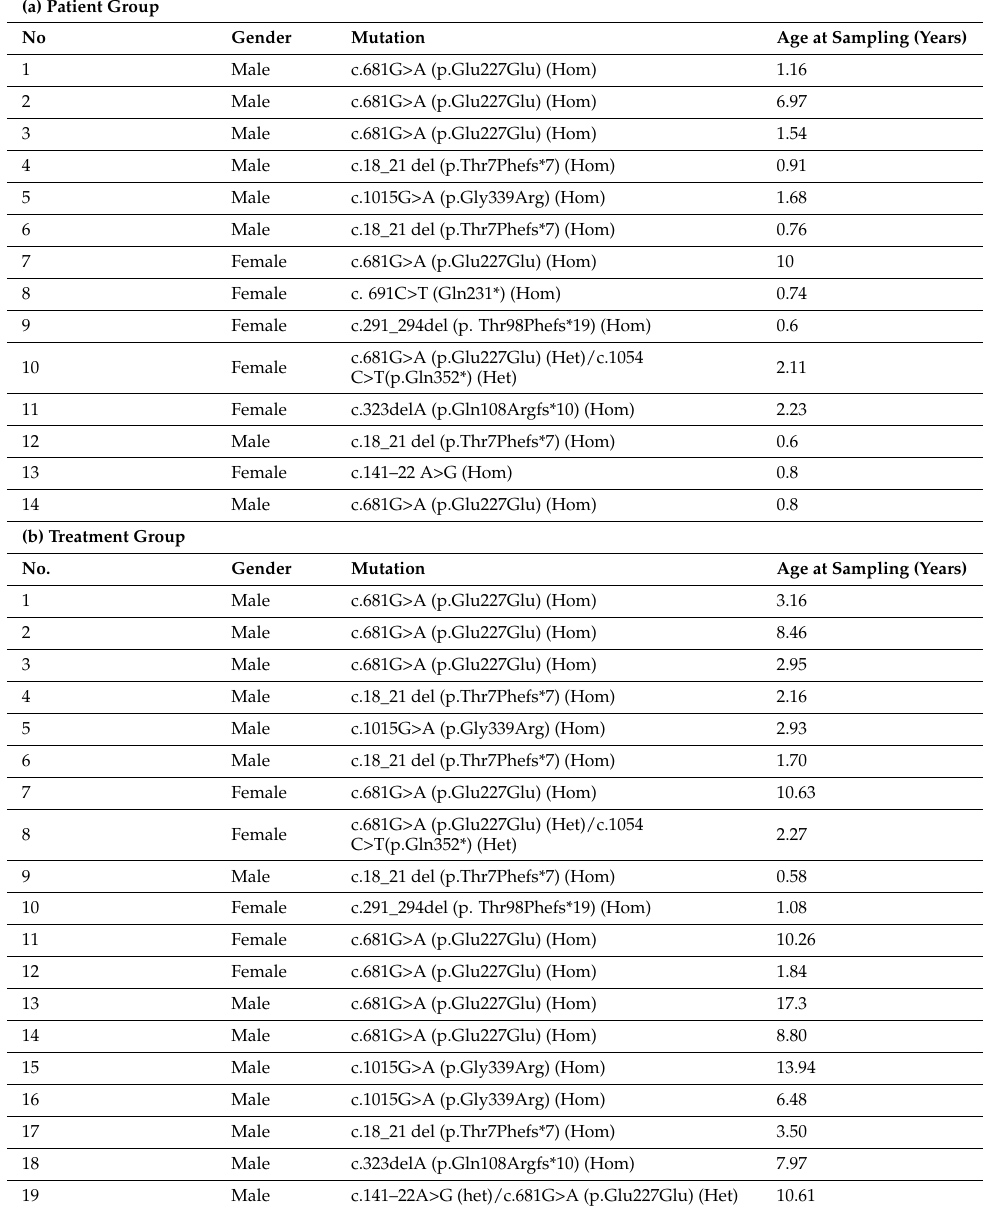
Table 1. Gender, age at sampling, and mutation detected in the patient and treatment